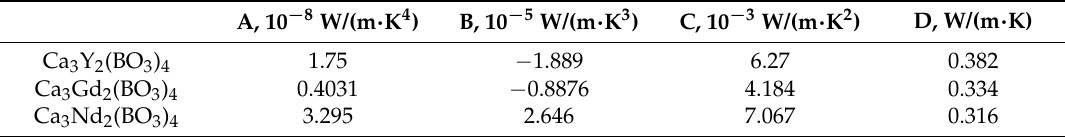
Table 3. A, B, C, and D coefficients of Equation (1) describing the thermal conductivity of Ca 3 RE 2 (BO 3 ) 4 (RE = Y, Gd, Nd)